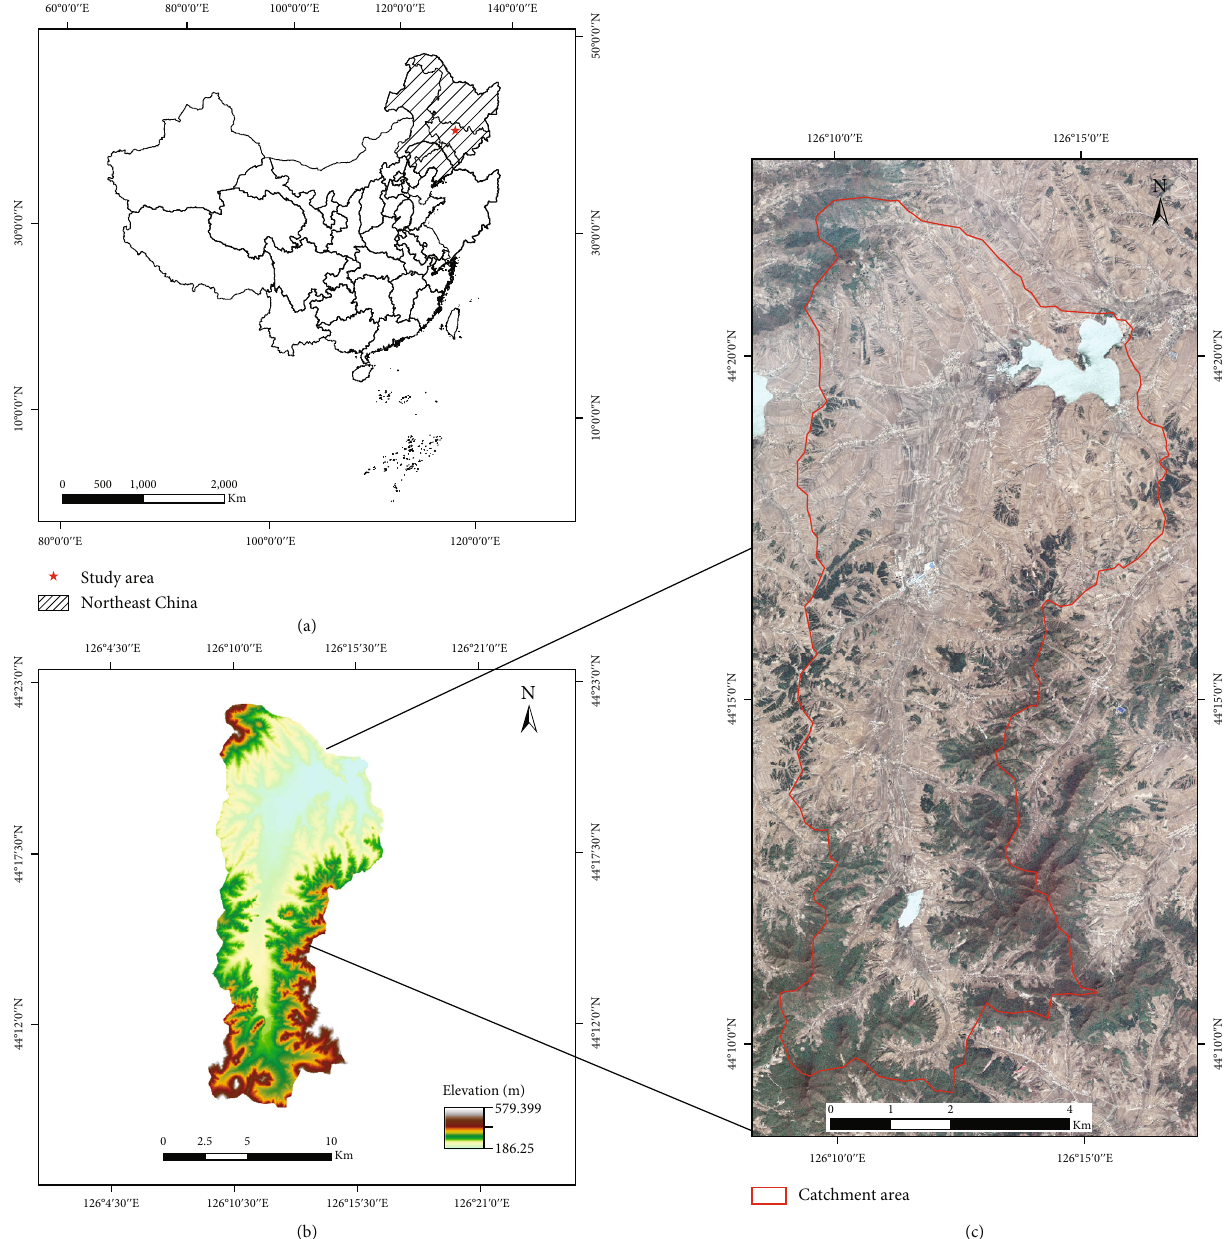
Figure 1: (a) The study area located in Northeast China. (b) DEM of the study area. (c) Pleiades-1B satellite image including the Sancha River catchment (27 April